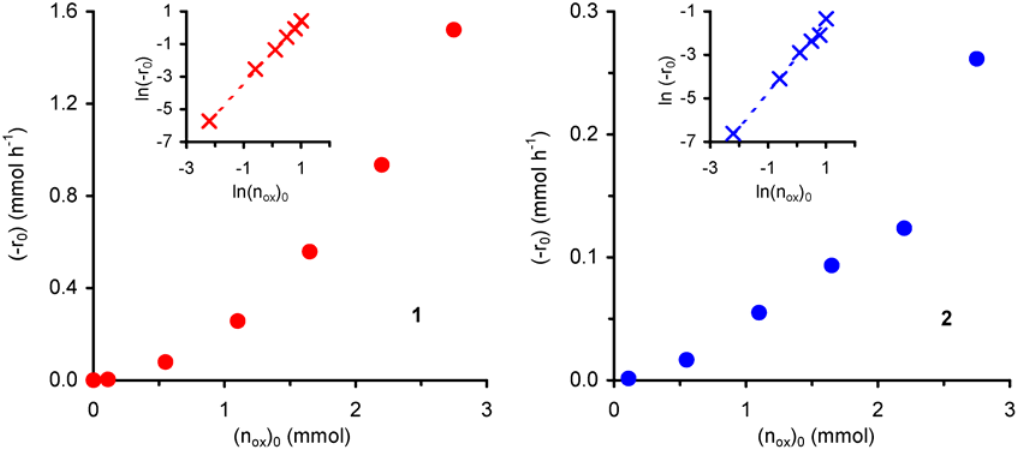
Figure 5. Dependence of the initial rate of cyclooctene epoxidation (with t- BuOOH in decane), catalysed by compounds 1 or 2 , as a function of the initial amount of